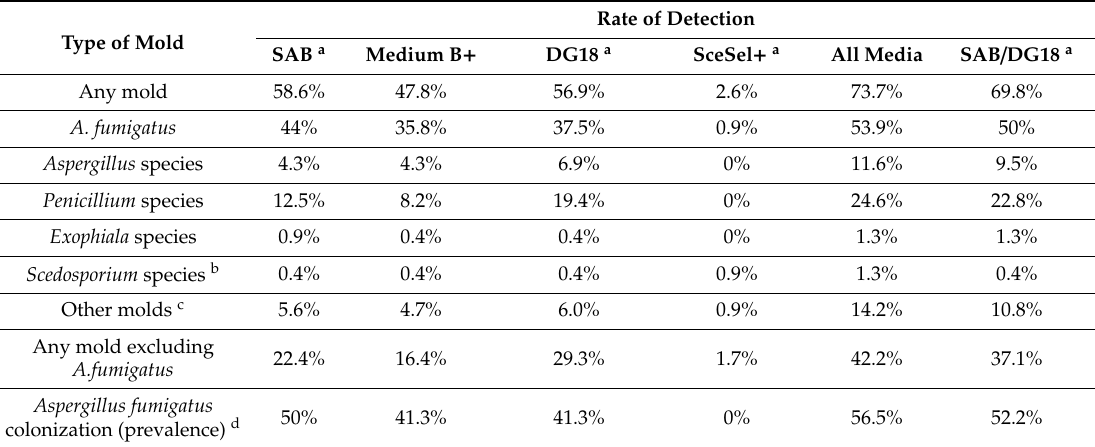
Table 2. Detection rate of individual culture media for molds.